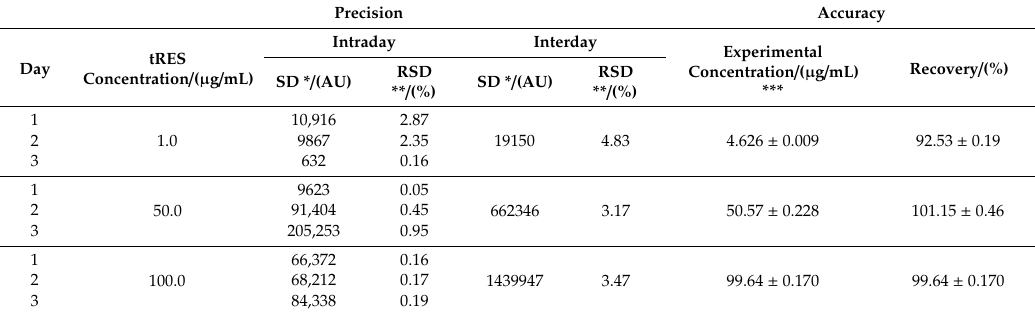
Table 2. Results achieved for the intraday and interday precision of the method and results found for method accuracy.